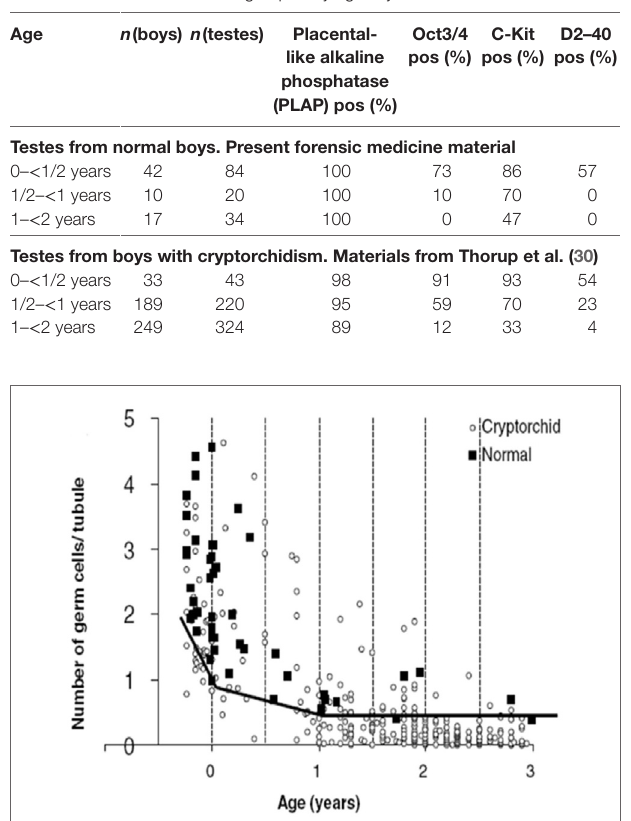
TaBle 3 | Percentage of testes with a positive reaction to each of the immunohistochemical markers grouped by age in years.